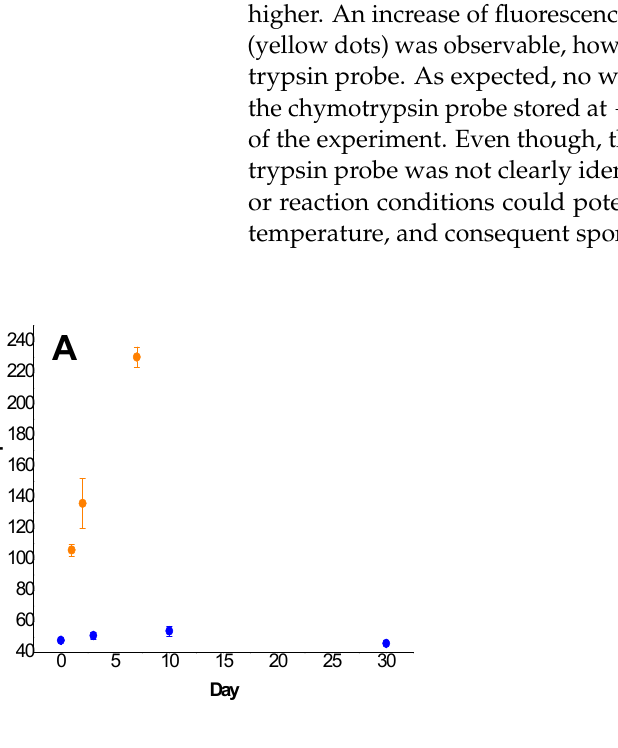
Figure S2: On-resin synthesis of chymotrypsin linker (yield: 75%). Figure S3: LC-MS analysis of chemically cleaved compound from Resin 1. Figure S4: LC-MS analysis of chemically cleaved com- pound from Resin 2. Figure S5: LC-MS analysis of chemically cleaved compound from Resin T3. Figure S6: LC-MS analysis of chemically cleaved compound from Resin T4. Figure S7: LC-MS